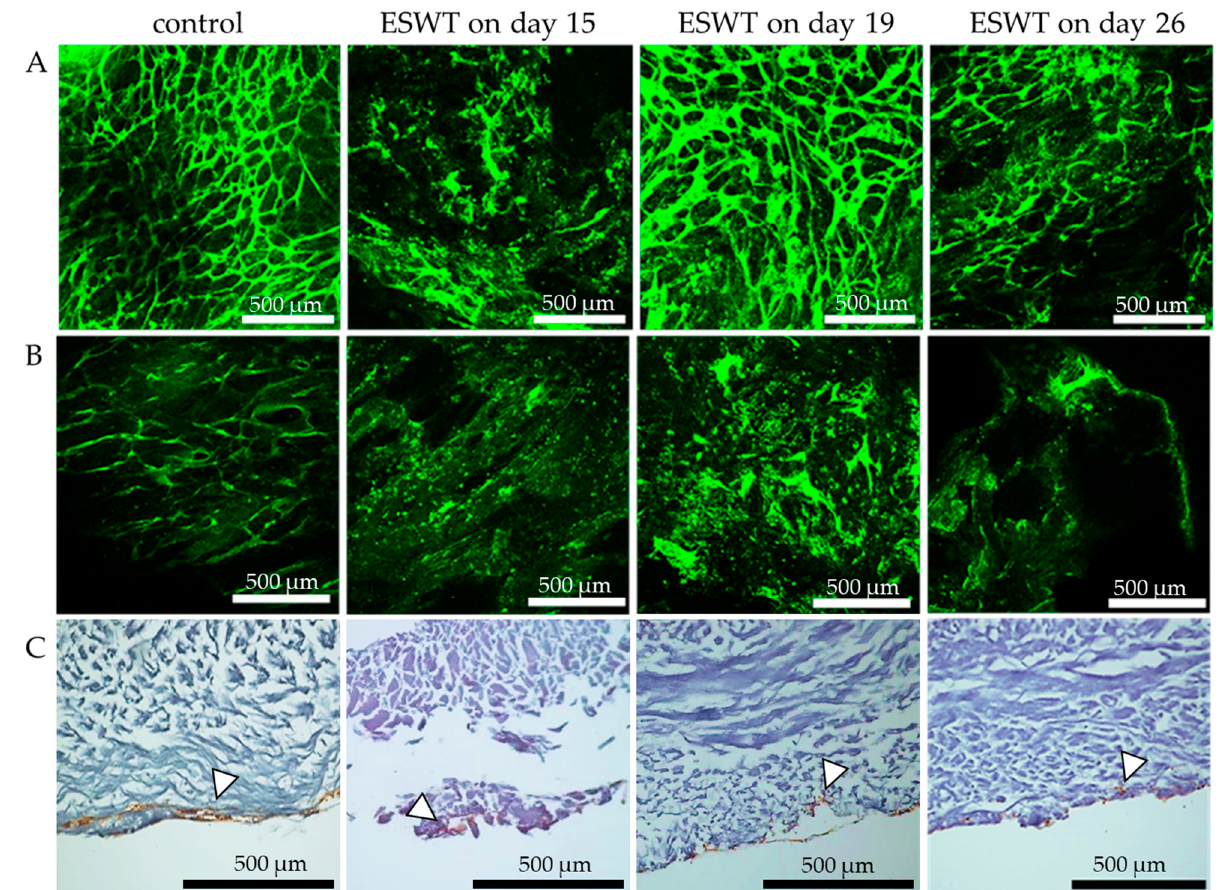
Figure 5. Formation of vascular-like structures and localization of endothelial cells on day 33 of bi- culture and tri-culture on collagen matrices after treatment with ESWT. ( A ) Bi-cultures of fibroblasts and endothelial cells or ( B ) Tri-cultures of fibroblasts, epithelial cells and endothelial on collagen matrices were treated with ESWT on culture day 15, day 19, or day 26 and fixed on culture day 33. Untreated bi- or tri-culture fixed on culture day 33 served as the control. Vascular-like structures were analyzed with confocal fluorescence microscopy after CD31 staining. ( C ) The localization of endothelial cells in untreated and ESWT treated tri-cultures were analyzed by immunohistochemical CD31 staining (white arrows). In the images, the cell occlusive side of the collagen matrix is directed upwards, and the porous side is directed downwards. Scale bars represent 500 μ m.